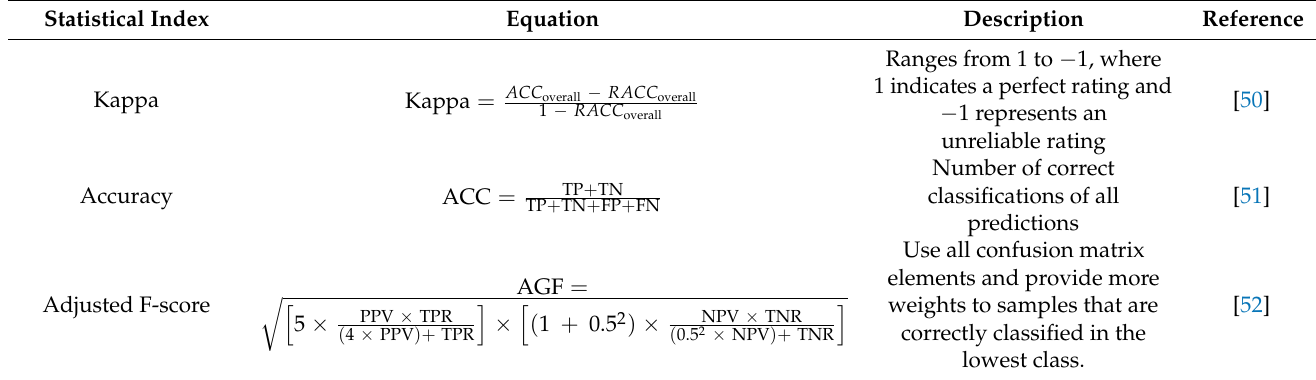
Table 3. Statistical indexes used to verify classification